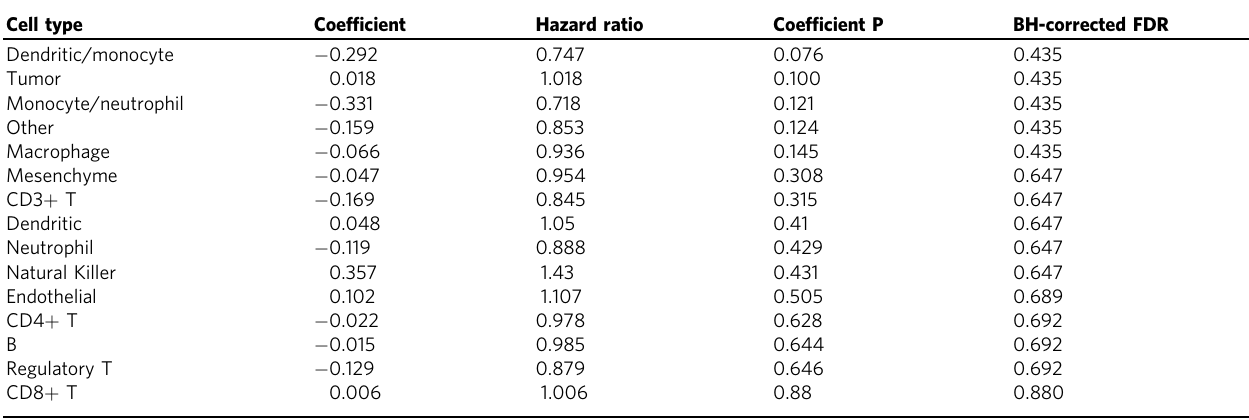
Table 3 Immune composition Cox regression results for